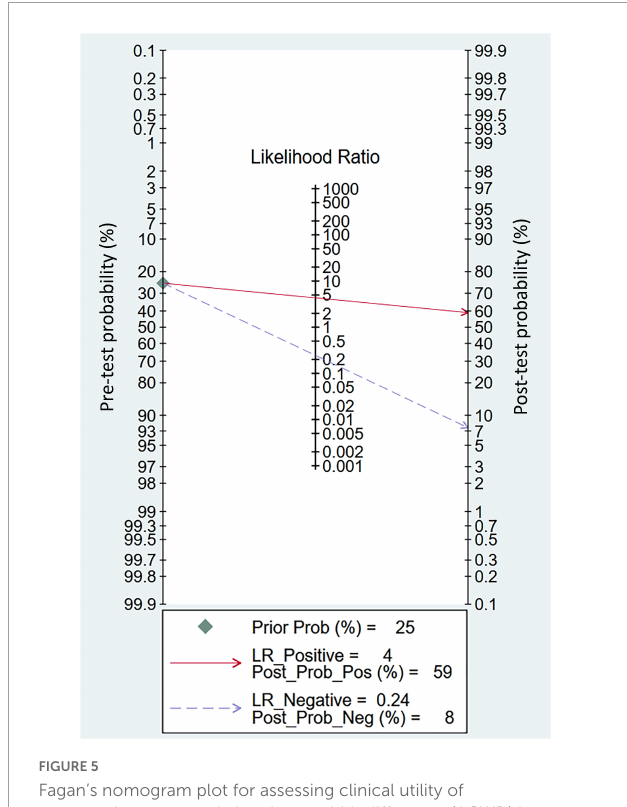
FIGURE5 Fagan’s nomogram plot for assessing clinical utility of sonography-measured air column width difference (ACWD) in post-extubation stridor (PES) prediction. LR, likelihood ratio; Prob, probability; Pos, positive; Neg,